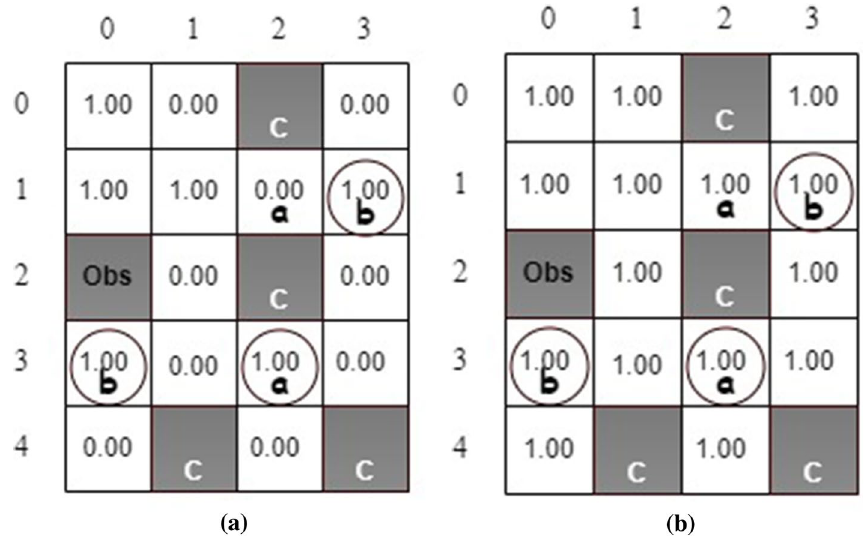
Figure 8. The results of (a) state safety values and ( b ) the maximum action safety